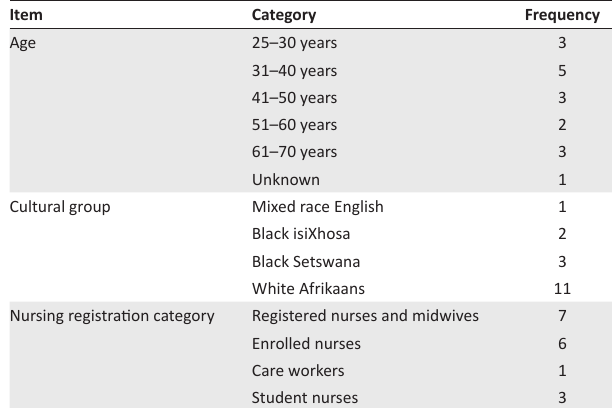
TABLE 1: Profile of participants ( N =